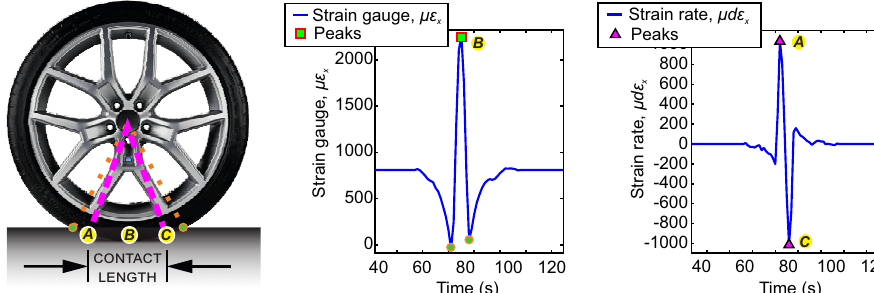
Figure 6. Characteristics of the contact trace on the circumferential strain curve ( ε x ) and on the derived strain curve ( d ε x ). Operating conditions: 0.8 bar , 0 ◦ , 50 km/h, 500